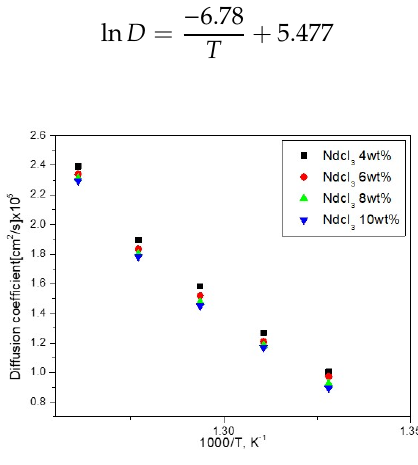
Figure 5. Cyclic Voltammograms of 4 wt% NdCl 3 in LiCl-KCl eutectic molten salt with scan rate; 50, 100, 200, 300 mV/s at 773K.